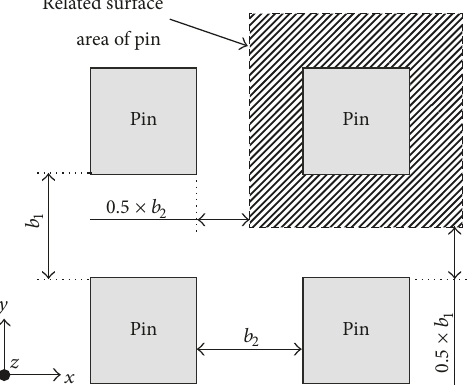
Figure 5: Definition of related surface area of the pins.